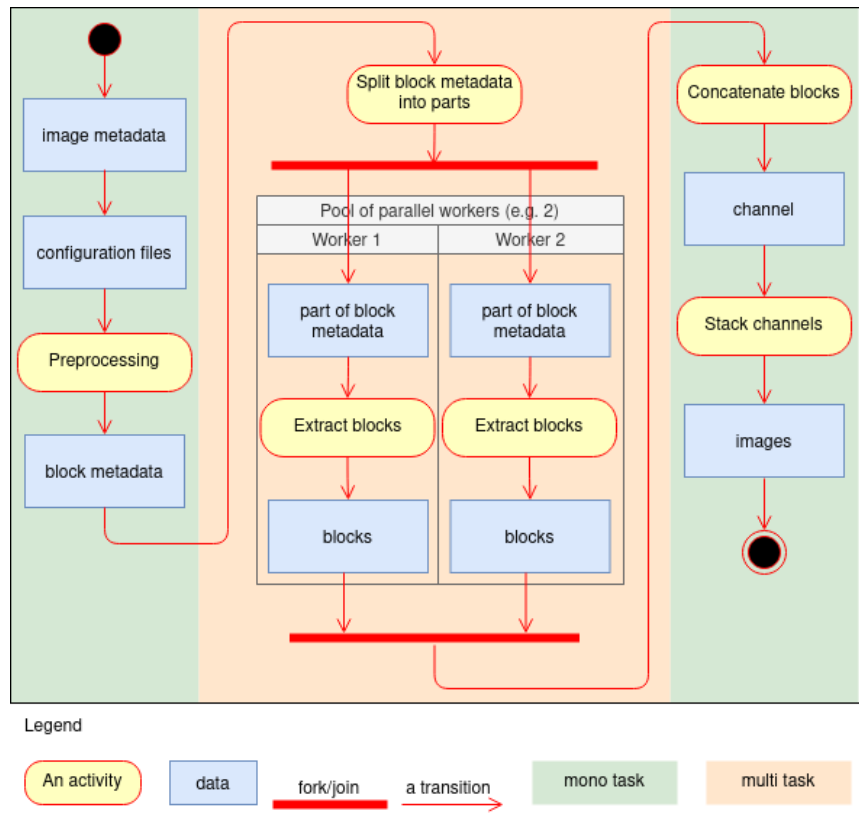
Figure 3. UML2 activity diagram of the image extractions using the NXTensor